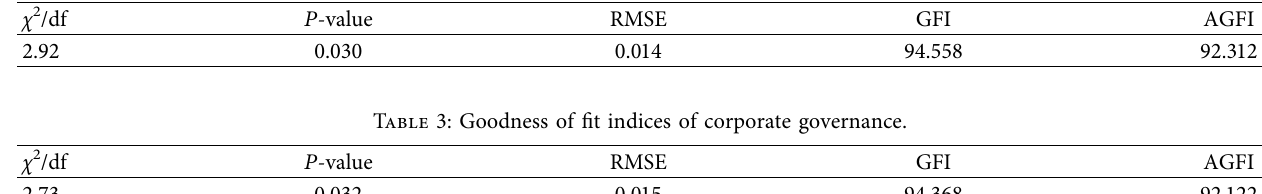
Table 2: Goodness of fit indices of ownership structure.